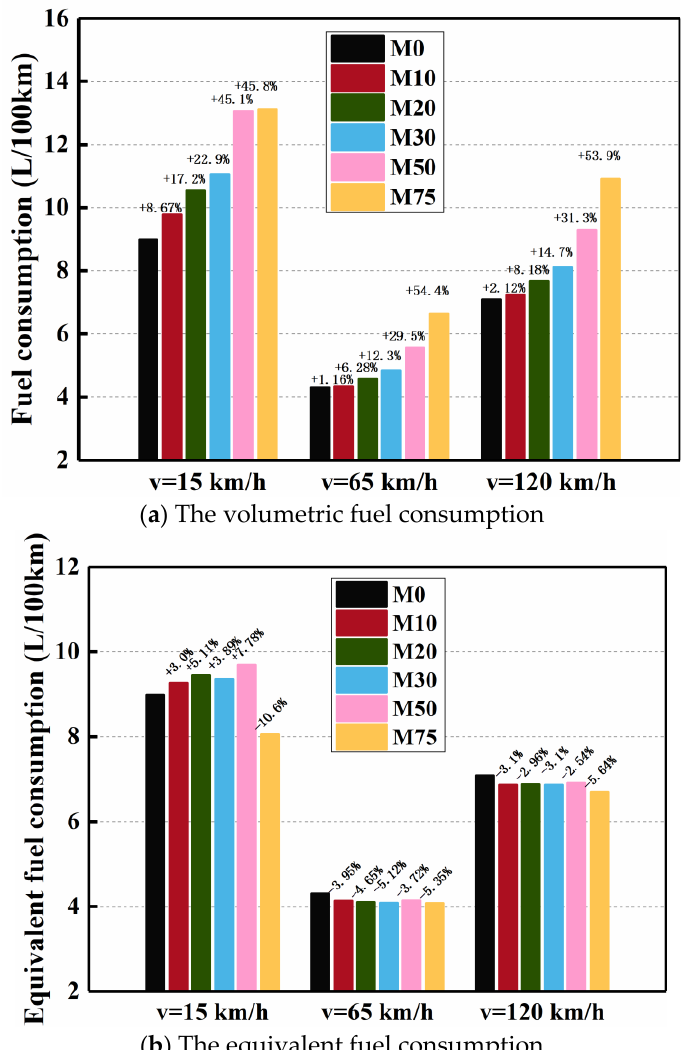
Figure 3. Effects of different methanol blending ratios on fuel consumption at different vehicle speeds.